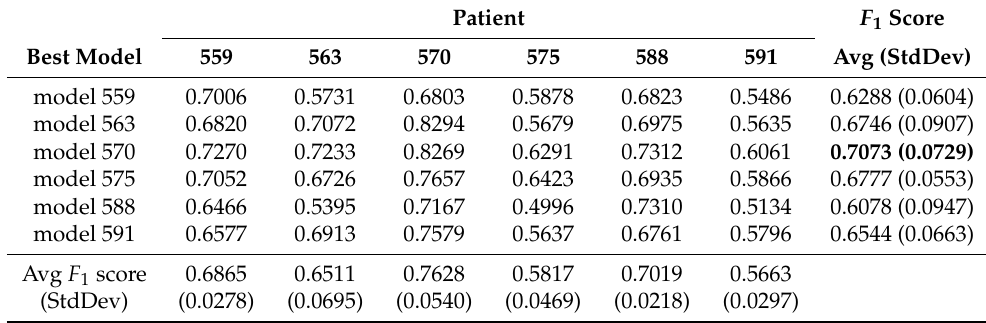
Table 5. Results of the non-FL approach. The best average F 1 score is reported in bold.